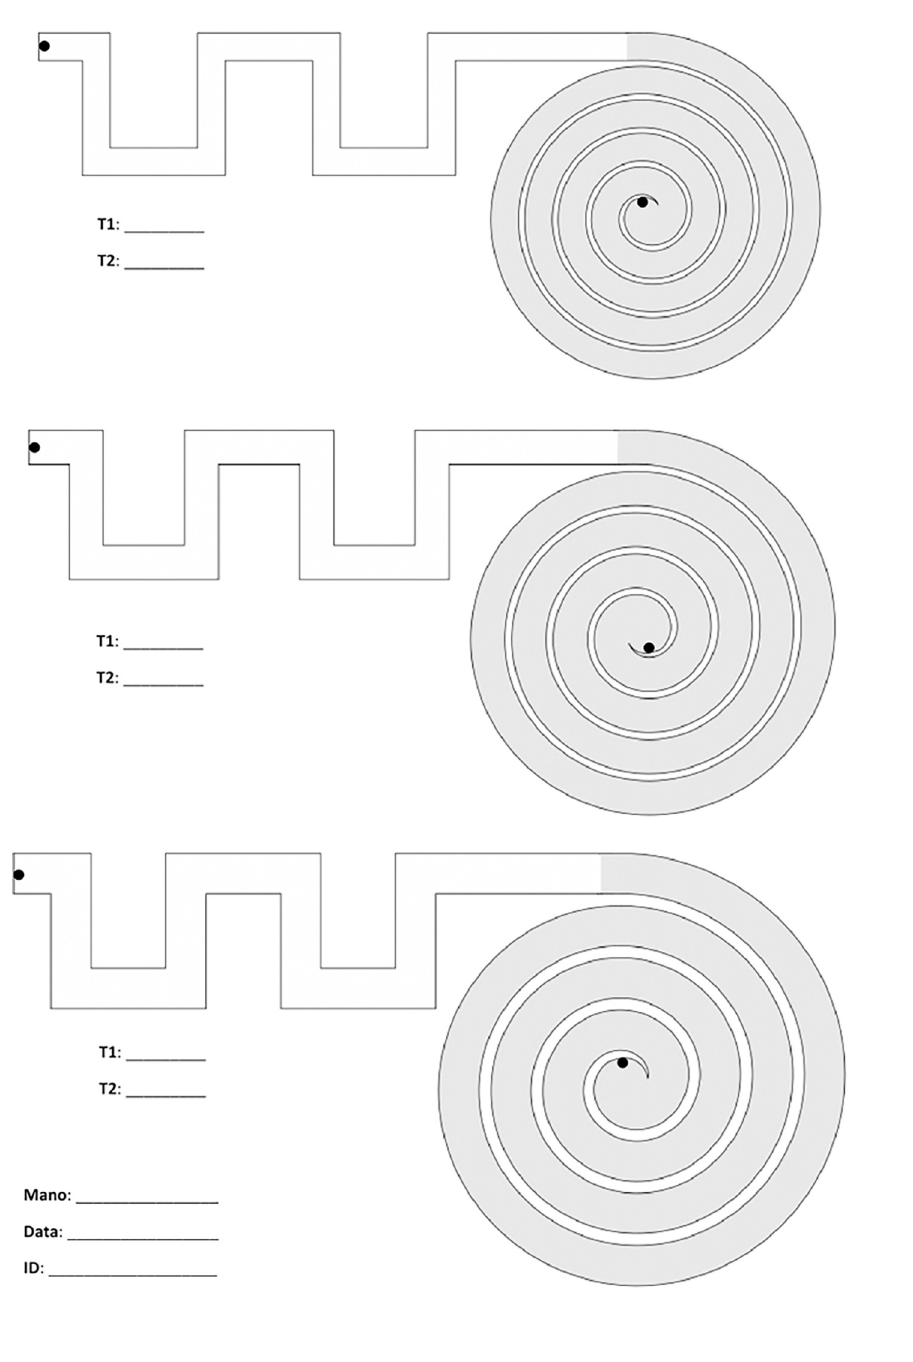
Fig 1. SpAcCo test: Three paths are present on each sheet, and they must be completed from the bottom (largest path) to the top (smallest path).